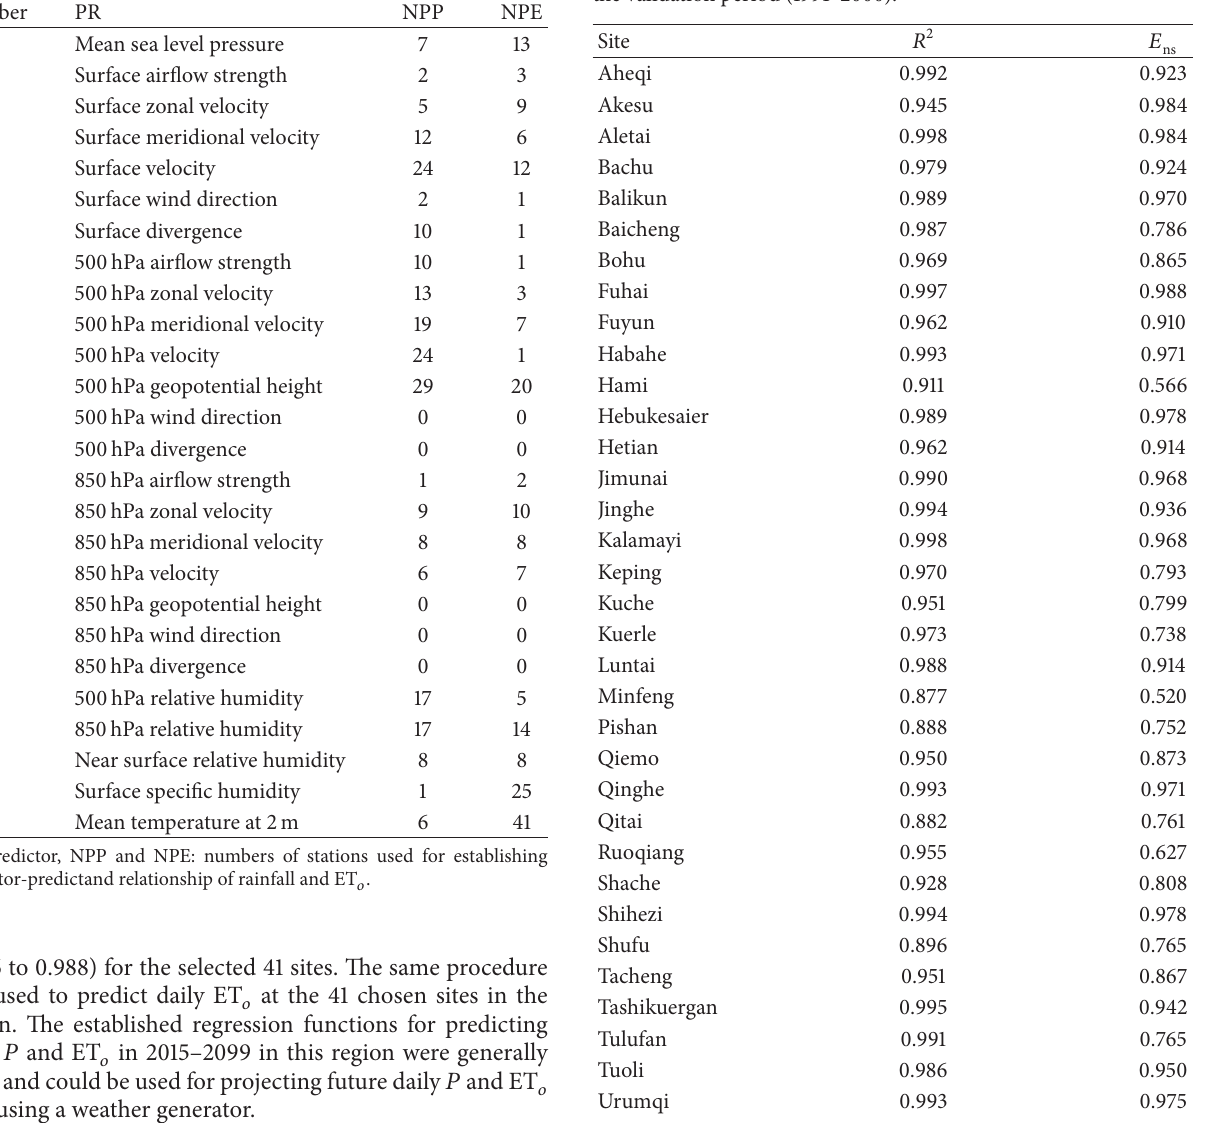
Table 4: The selected predictors used for developing a relationship between the predictand and predictor.